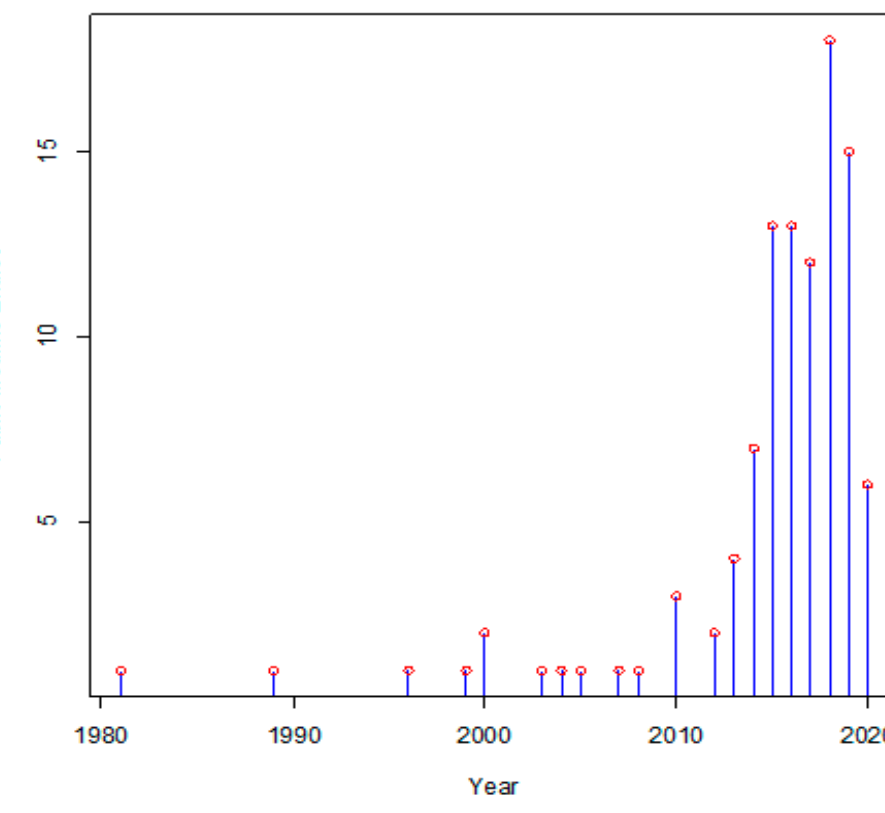
Figure 1. Publications on masters athletes, plotted against year of publication. Date are the result